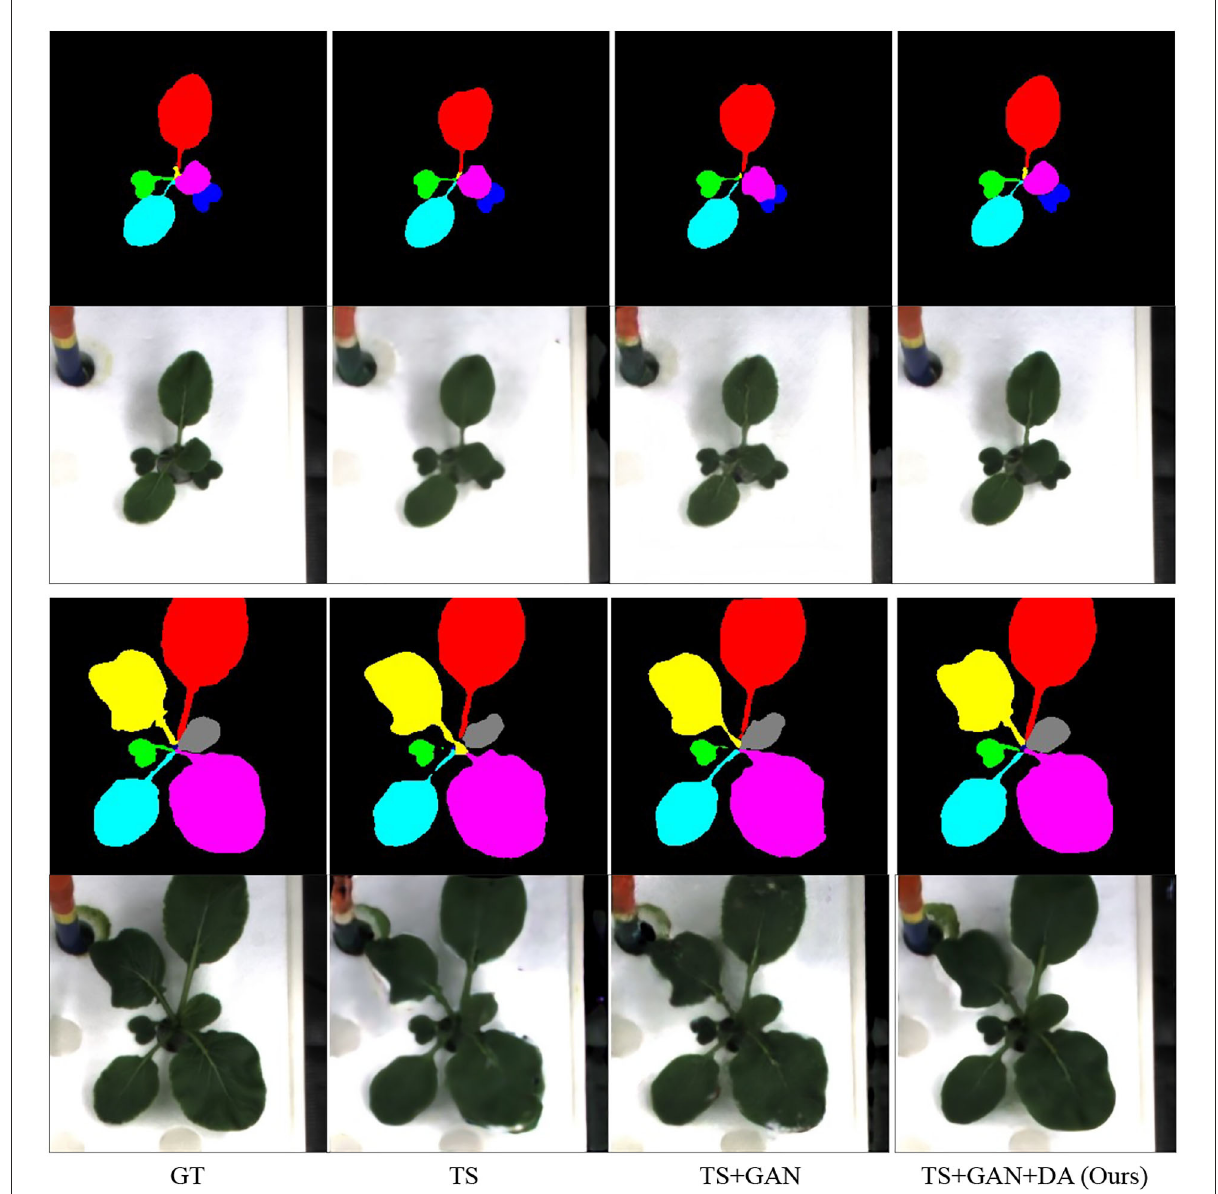
FIGURE8 Ablation study of our algorithm. GT denotes the ground truth. TS and DA suggest time-series and our proposed time-series data augmentation.